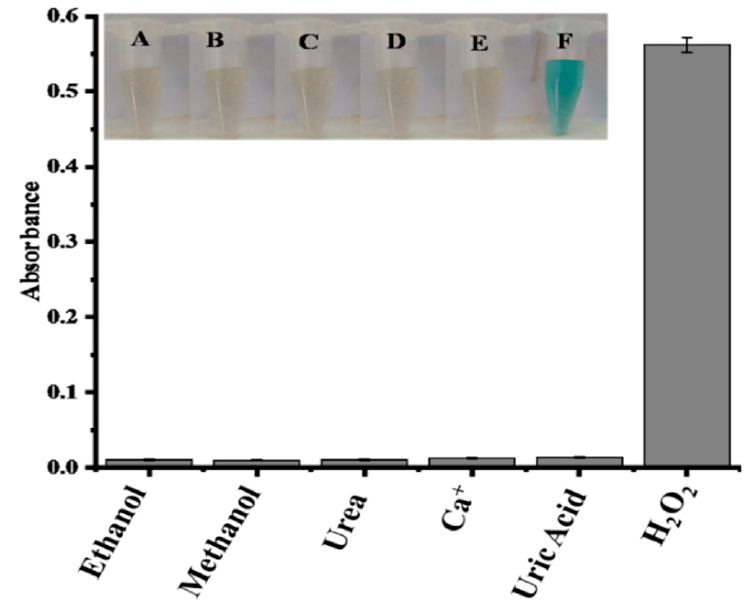
Figure 12. The interference study of H 2 O 2 (3.6 × 10 − 7 M) with other analytes such as methanol, ethanol, urea, Ca +2 , and uric acid having concentration of 1.0 × 10 − 6 M.